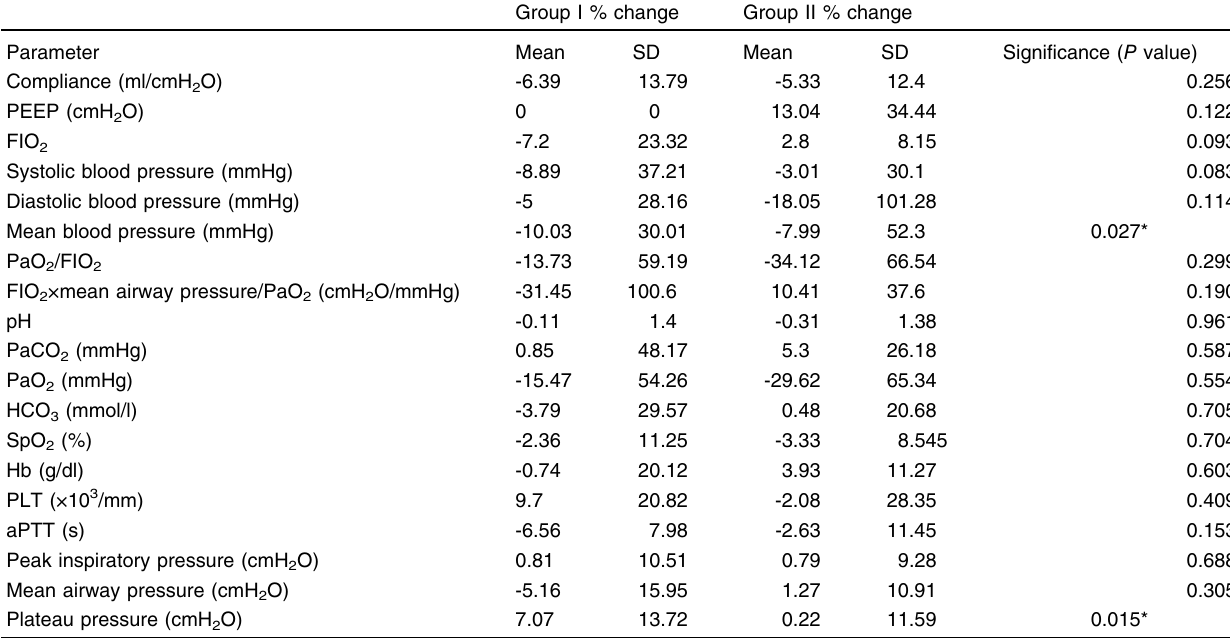
Table 15 Comparison between the two groups regarding percentage change from days 1 to 4 [(d1 value-d4 value)/d1 value×100] using the Mann–Whitney U -test